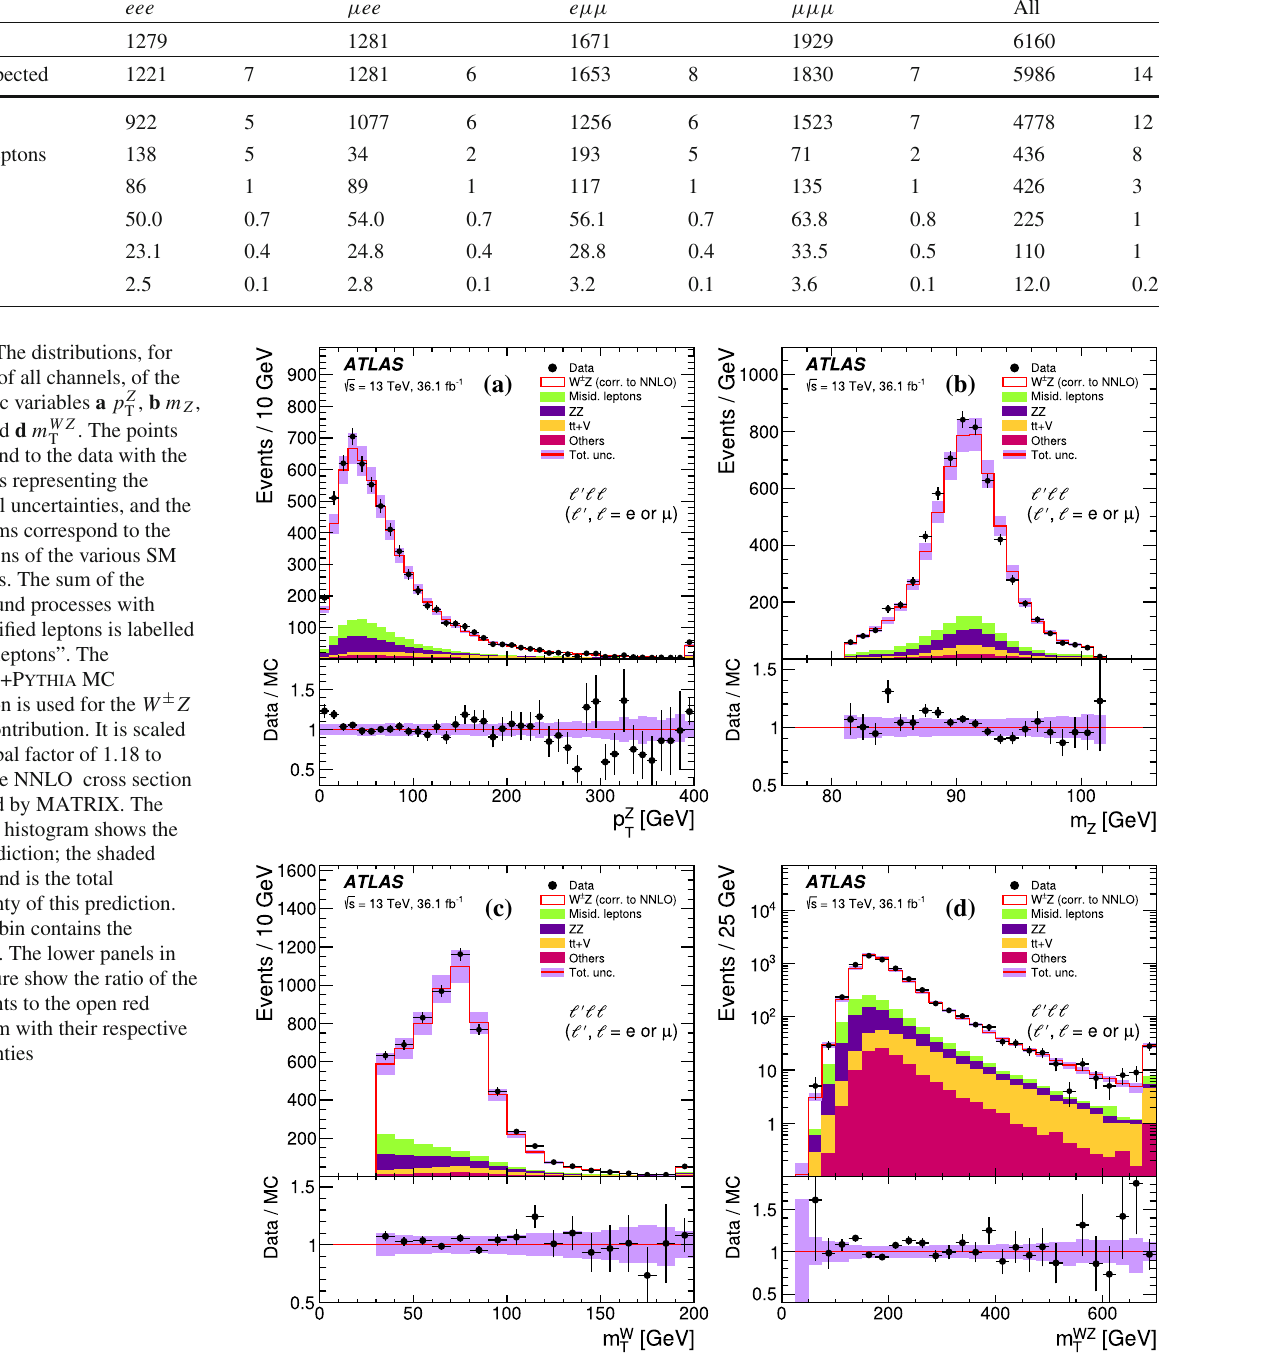
prediction is scaled by a global factor of 1 . 18 to match the NNLO cross section predicted by MATRIX . The sum of background events contain- ing misidentified leptons is labelled “Misid. leptons”. Only statistical uncertainties are reported